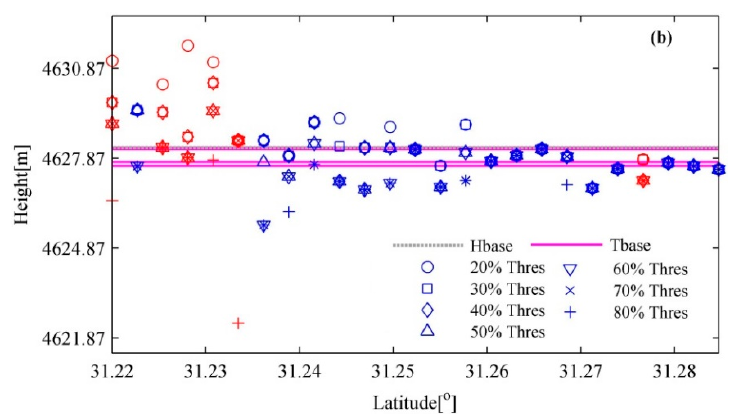
Figure 6. ( a ) All peak heights for the track over Ngoring Lake on 5 June 2011. ( b ) All peak heights for the track over Dawa Co on 30 December 2014. Blue and red symbols represent the selected and removed observations, respectively.